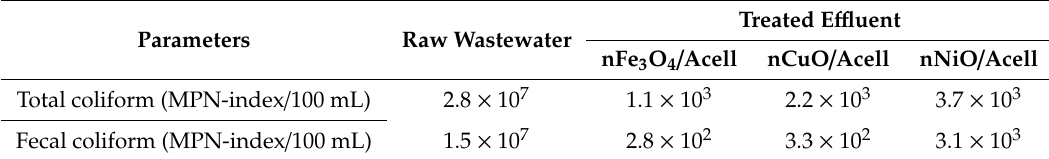
Table 3. Bacterial markers of crude household wastewater.